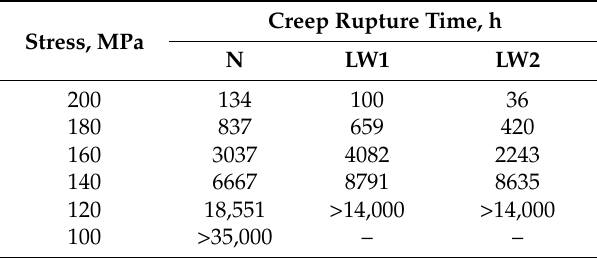
Figure 17. Creep rupture results of 9Cr-3W-3Co steels and commercial 9–12% Cr steels at 650 °C. Table 2. Creep rupture time of 9Cr-3W-3Co steels at 650 °C.